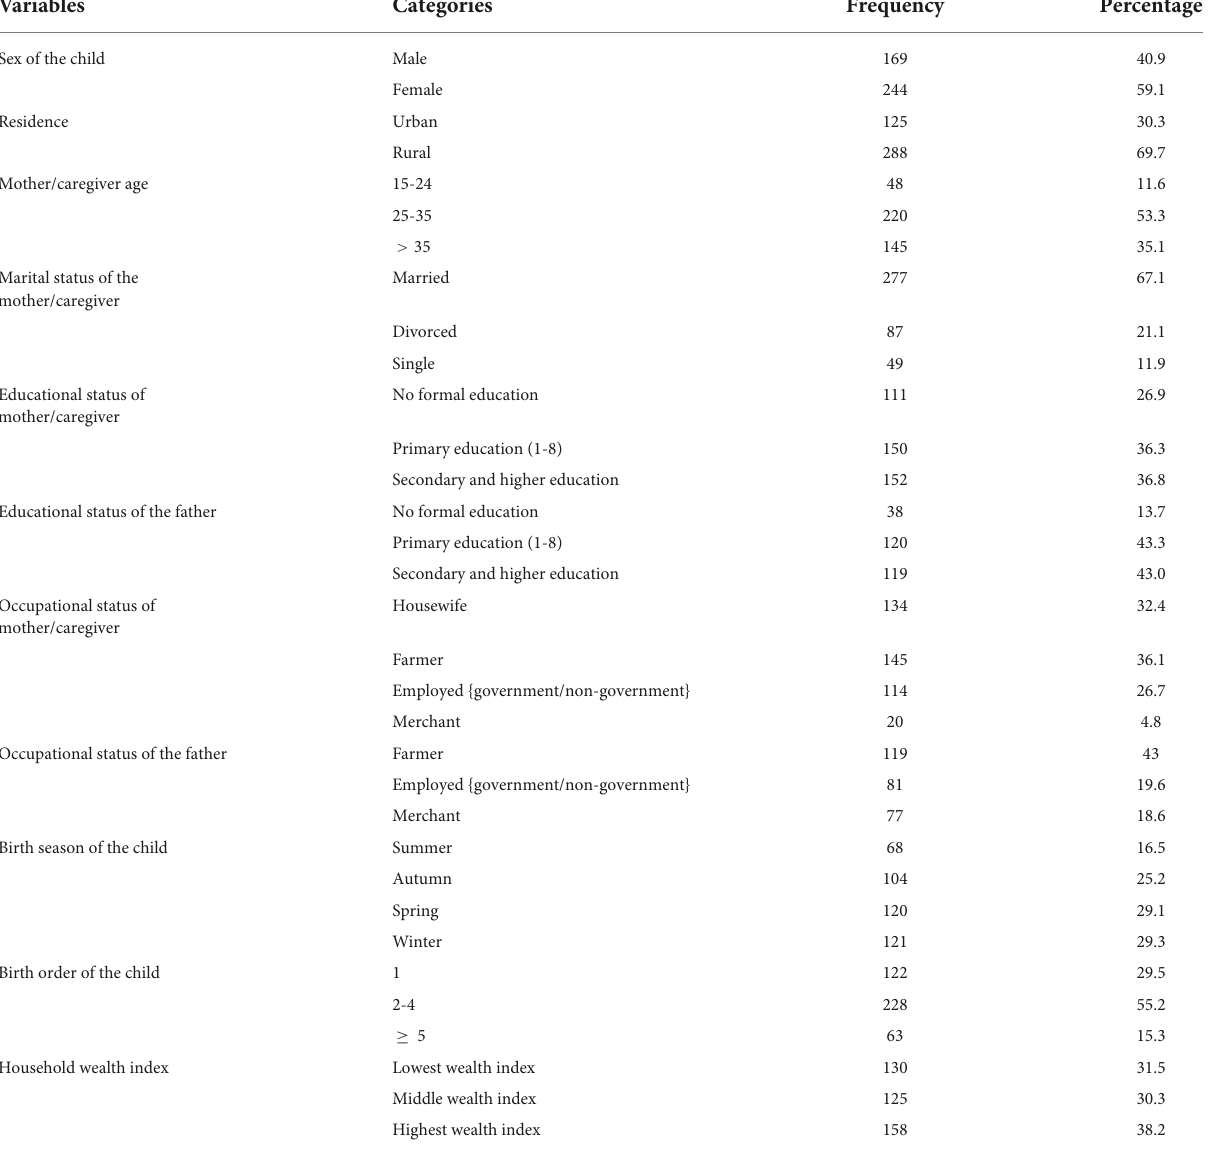
TABLE 2 Sociodemographic characteristics of the respondents and the child for vaccination timeliness and associated factors among children aged 12–23 months in Debre Libanos district North Shewa Zone, Oromia Regional State, Ethiopia 2021.